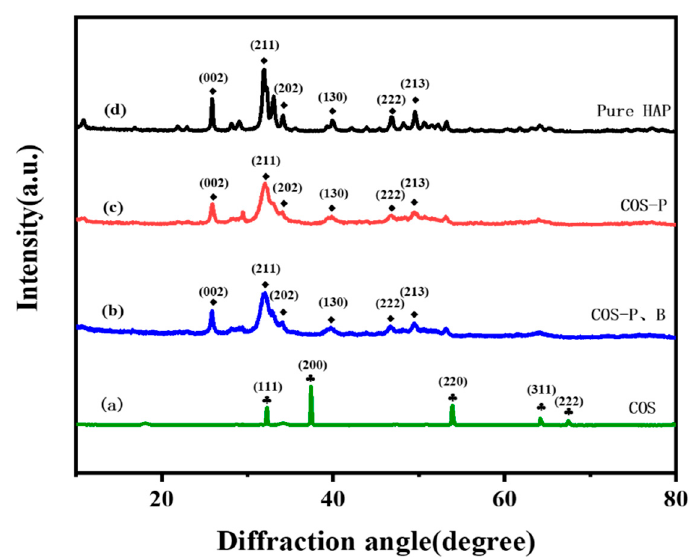
Figure 2. The XRD patterns of material and reactive residual solids ( a : COS, b : COS after B and P reaction, c : COS after P and d : pure HAP).